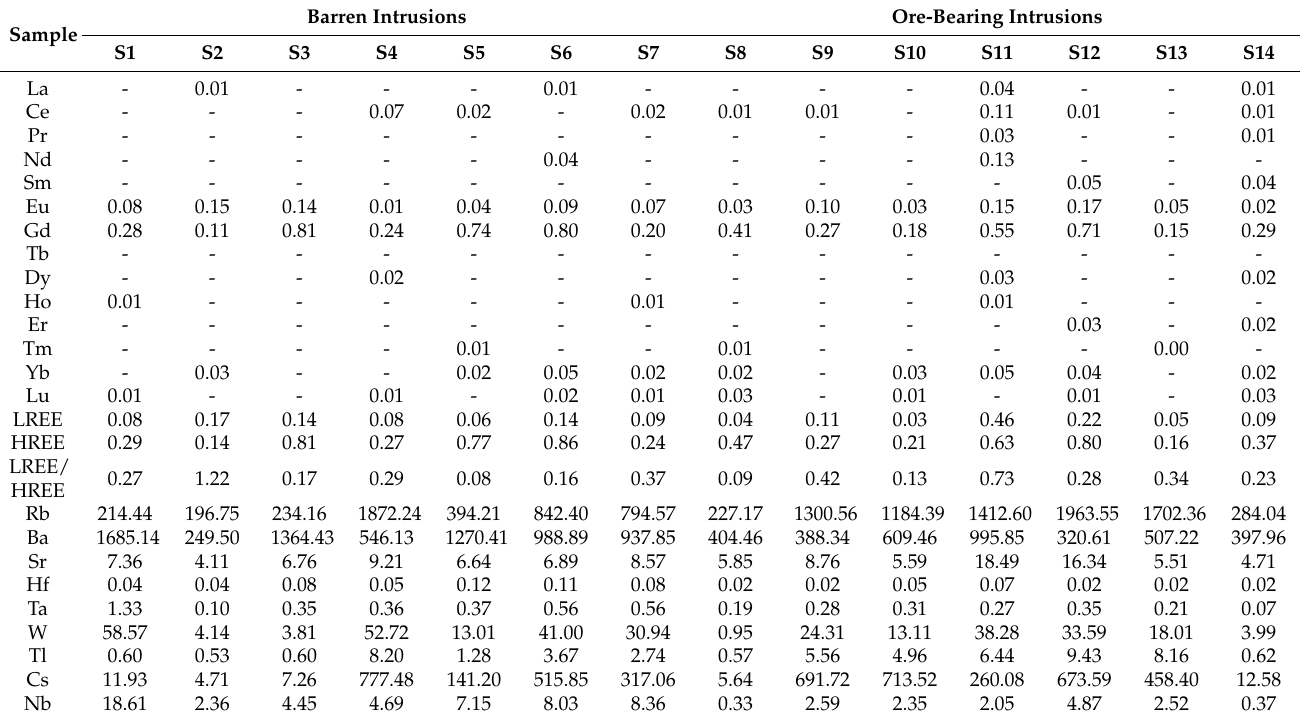
Table 2. Results of the LA-ICP-MS of white micas